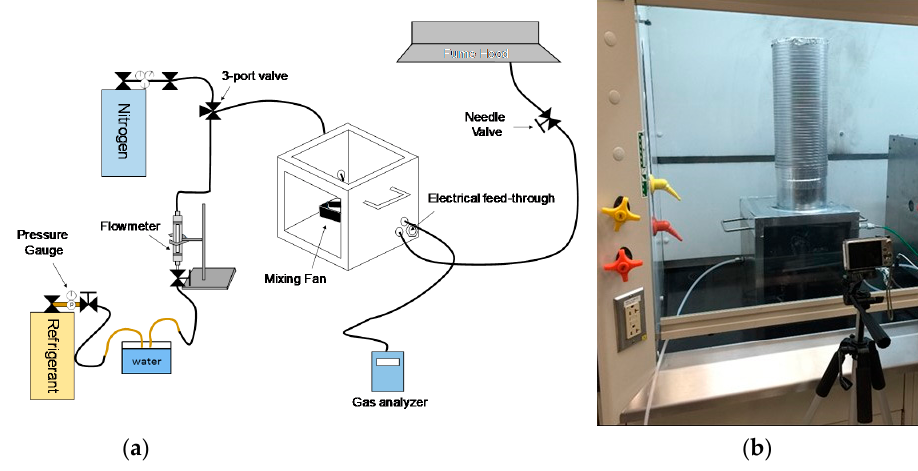
Figure 1. ( a ) Experimental setup; ( b ) Image of the chamber and its chimney.